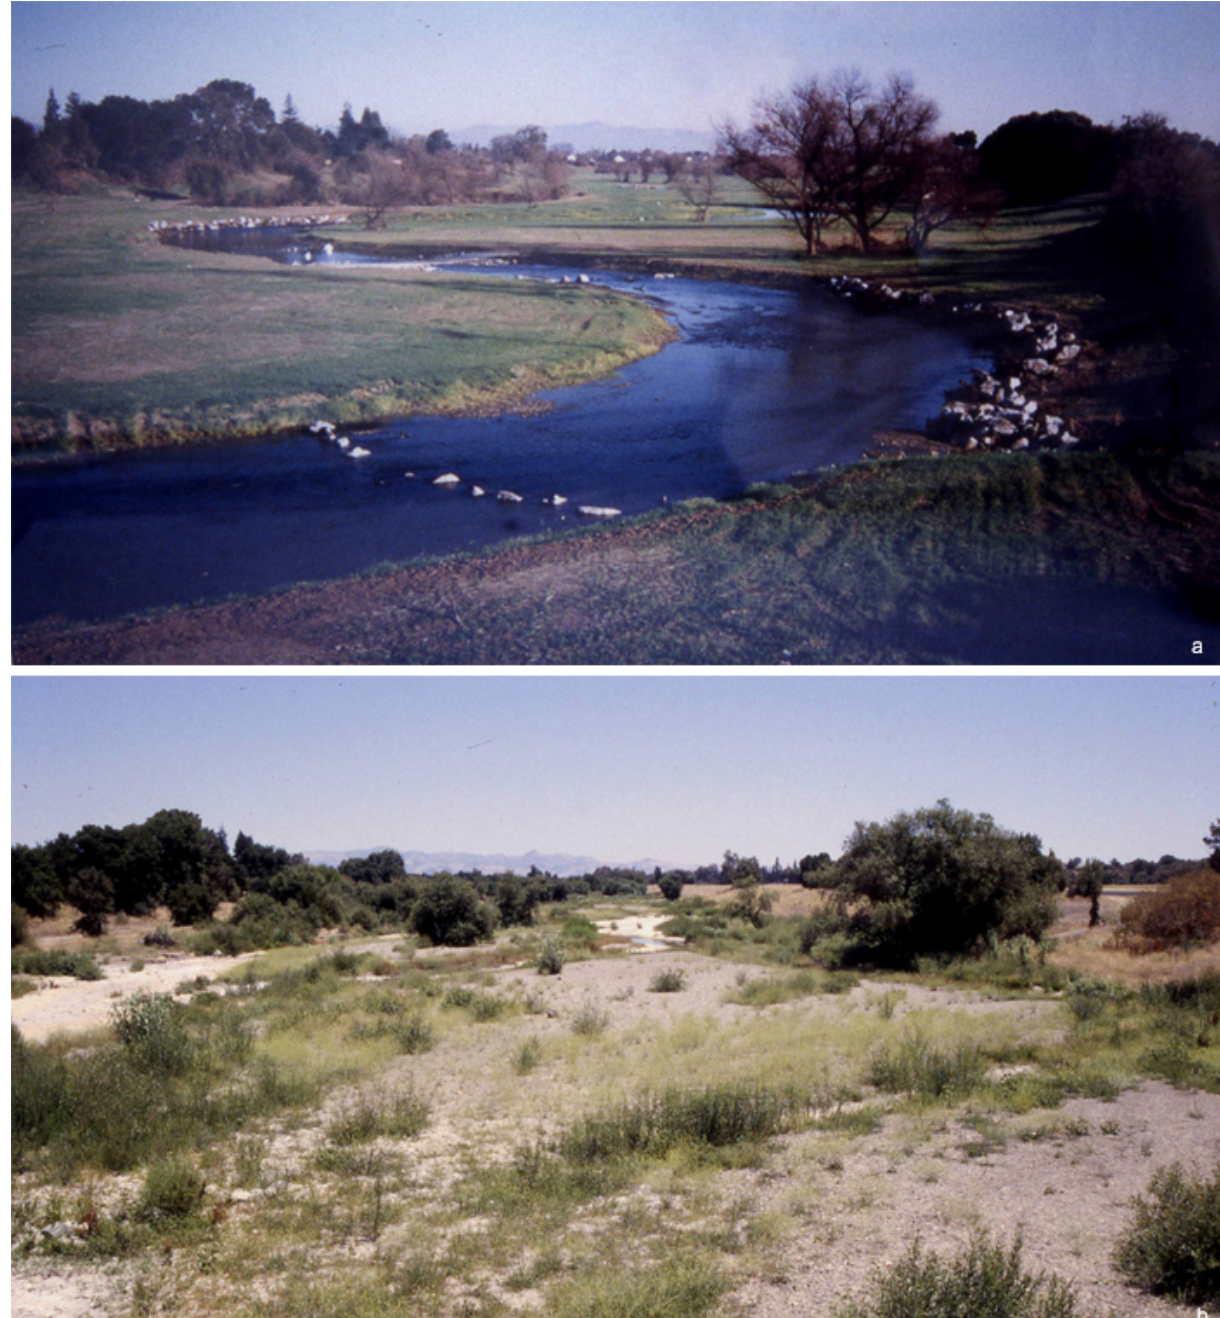
Fig. 8 . Views downstream from Santa Teresa Boulevard bridge to project reach on Uvas Creek in (A) January 1996, two months after construction, and (B) July 1997, after the project washed out in February 1996. Photograph A courtesy of the City of Gilroy, photograph B by the